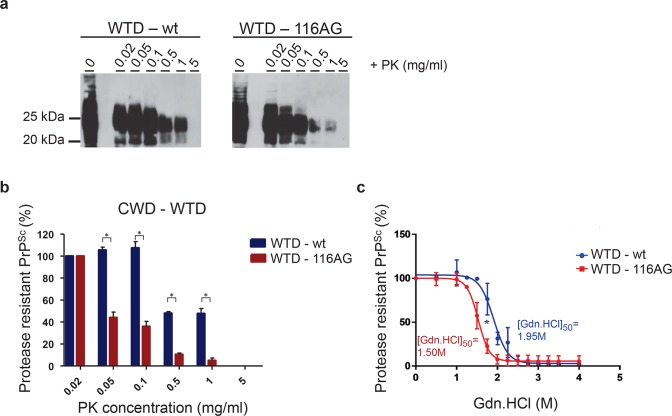
Biochemical properties of WTD isolates.Resistance to PK was assessed using different PK concentrations to digest wt (left panel) and 116AG (right panel) brain homogenates. (a) The PrPres Western blot pattern was revealed using monoclonal antibody 4H11 and (b) assessed by densitometric analysis of PrPres signals. *P <0.05 refers to differences between PK resistance of wt (blue bars) and 116AG (red bars) and evaluated using unpaired student’s t-test (GraphPad Prism software). (c) Conformational stability of wt (blue line) and 116AG (red line) assessed by densitometric analysis of PrPres signals after guanidine denaturation followed by PK digestion. *P <0.05 refers to differences between [GdnHCl1/2] from best-fitted sigmoid curves evaluated using unpaired student’s t-test (GraphPad Prism software).